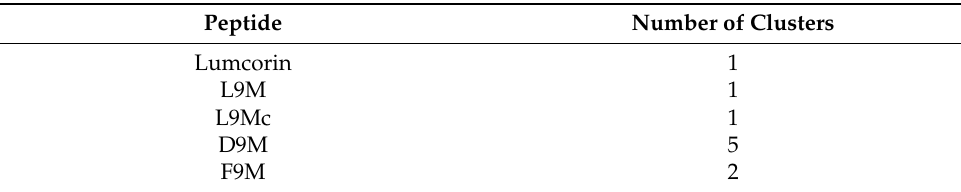
Figure 3. Representative structures of lumcorin peptides. From left to right, the first five conformations of lumcorin, ex- tracted from MD simulations, are presented using cartoon and licorice representations. The green and red spheres repre- sent the first and last alpha carbon of lumcorin, respectively. Table 2. Selection of the conformations for docking experiments. Table 2. Selection of the conformations for docking experiments.